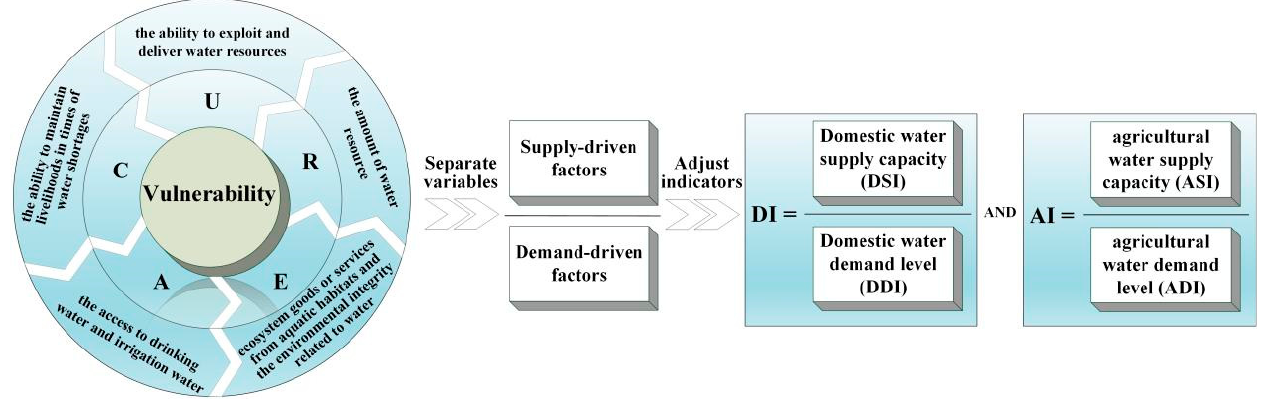
Figure 2. The construction process of frameworks for the water vulnerability and supply-demand balance index.